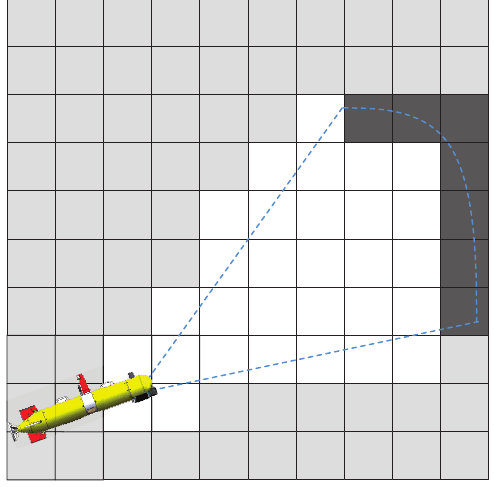
Figure 3. Example of the inverse measurement